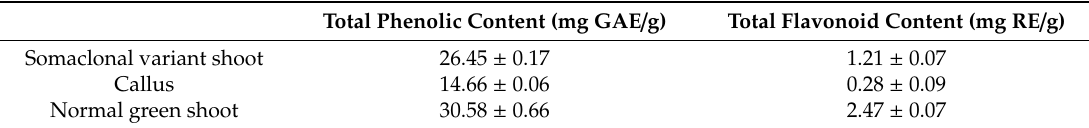
Table 8. Total phenolic and flavonoid content in the